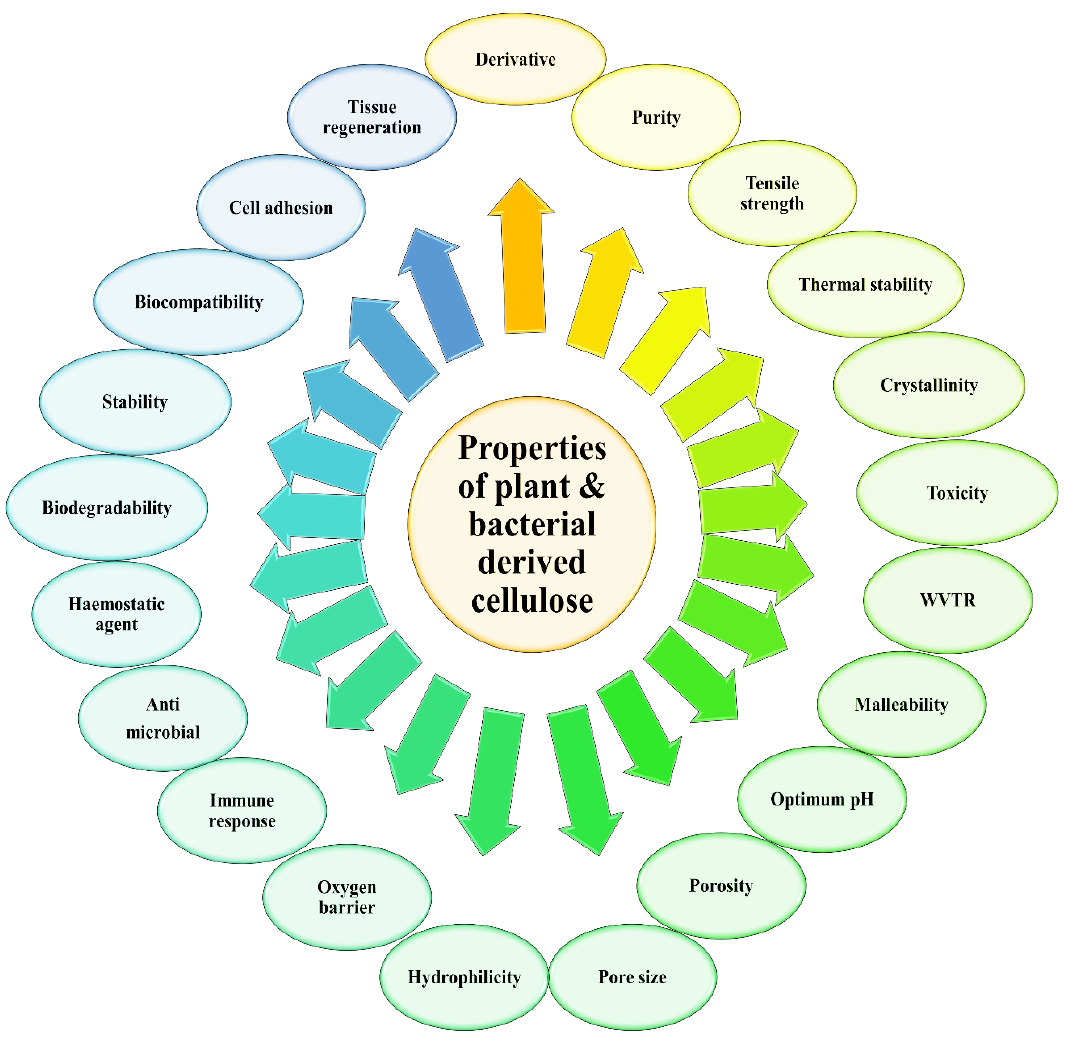
Figure 3. Related properties to be compared for plant and bacterial derived cellulose .